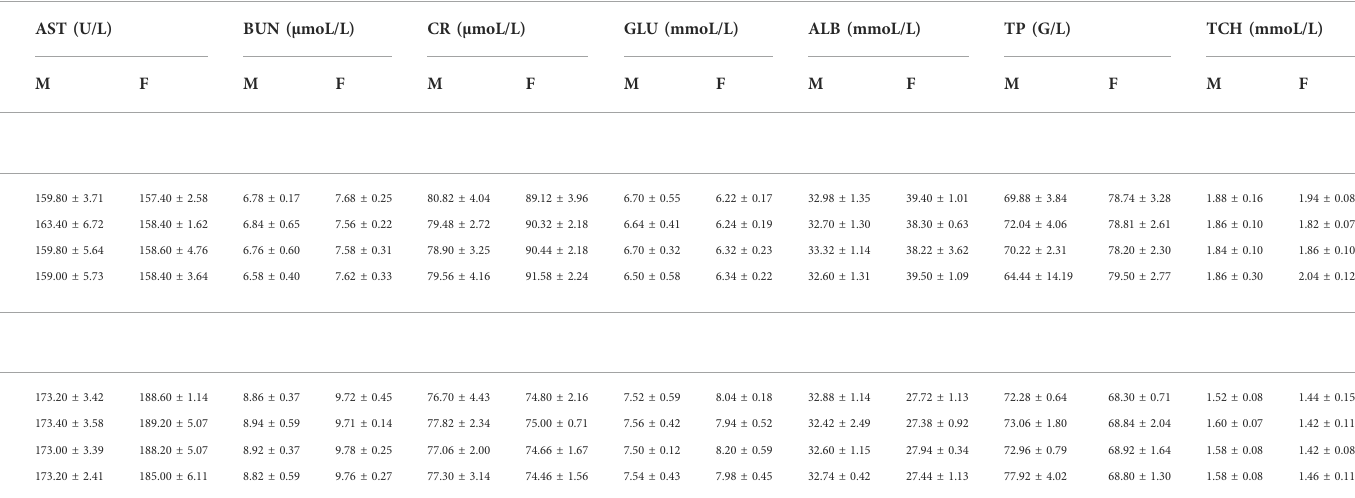
TABLE 4 Effect of feeding MCE for 90 and 180 days on serum biochemical parameters in rats. Serum biochemical parameters (Mean ± SD)